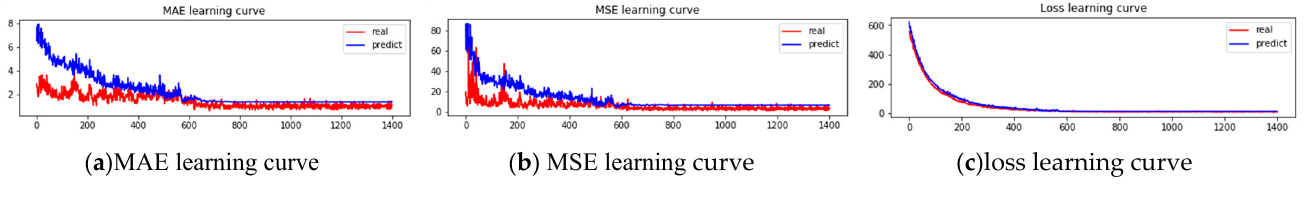
Figure 11. Learning curve.